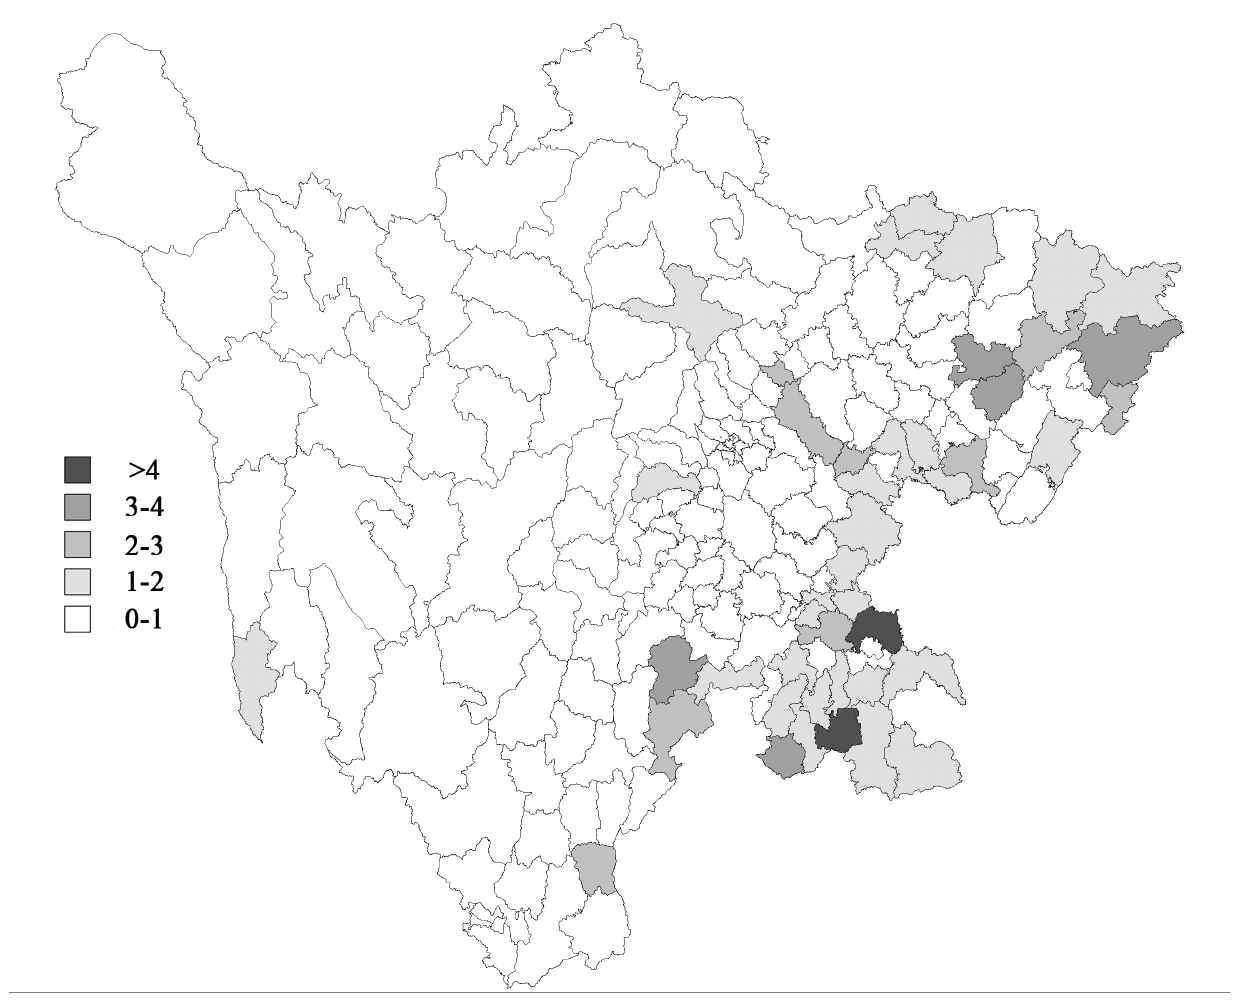
Figure 1. Choropleth map of empirical Bayes estimates of relative risk of Japanese encephalitis in Sichuan province in 2009.